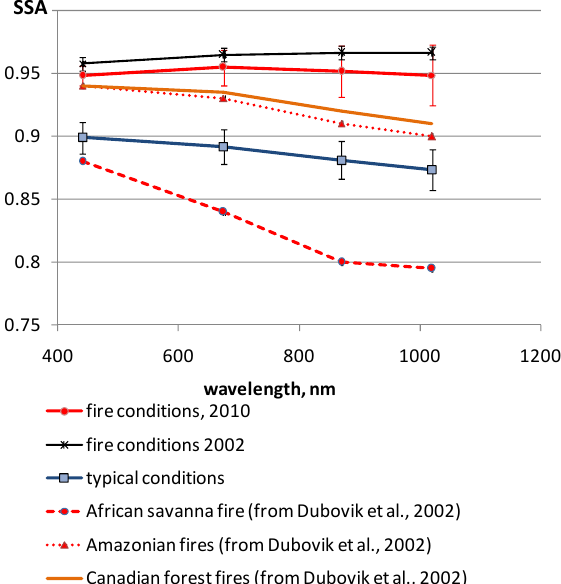
Fig.9. Spectral dependence of aerosol single scattering albedo (SSA) for Moscow Fig. 9. Spectral dependence of aerosol single scattering albedo fire conditions in 2010, 2002, and typical conditions with confidence intervals at (SSA) for Moscow fire conditions in 2010, 2002, and typical condi- 95%. In addition, the SSA values over other areas with biomass burning aerosol are tions with confidence intervals at 95%. In addition, the SSA values shown (Dubovik et al., 2002). over other areas with biomass burning aerosol are shown according to Dubovik et al. (2002).